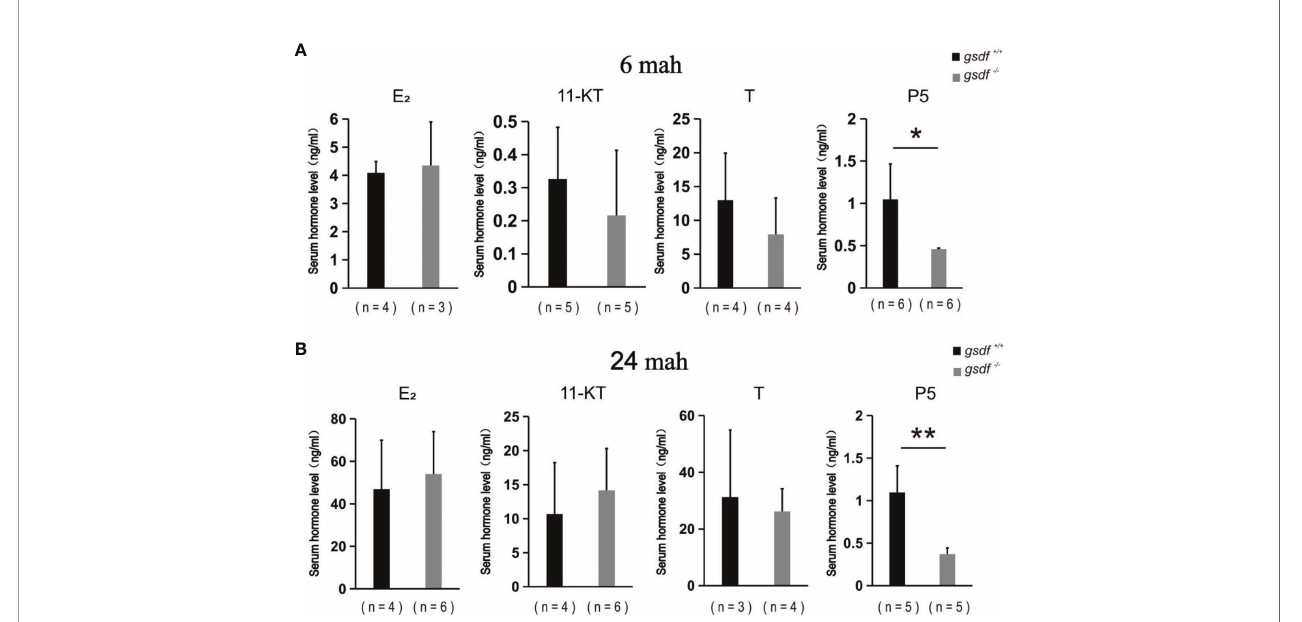
FIGURE 4 | Serum E 2, 11-KT, T and P5 levels of XX gsdf +/+ and gsdf - /- tilapia at 6 (A) and 24 (B) mah. Results are presented as mean ± SD. * and ** above the error bar indicate signi fi cant difference at P < 0.05 and P < 0.01,